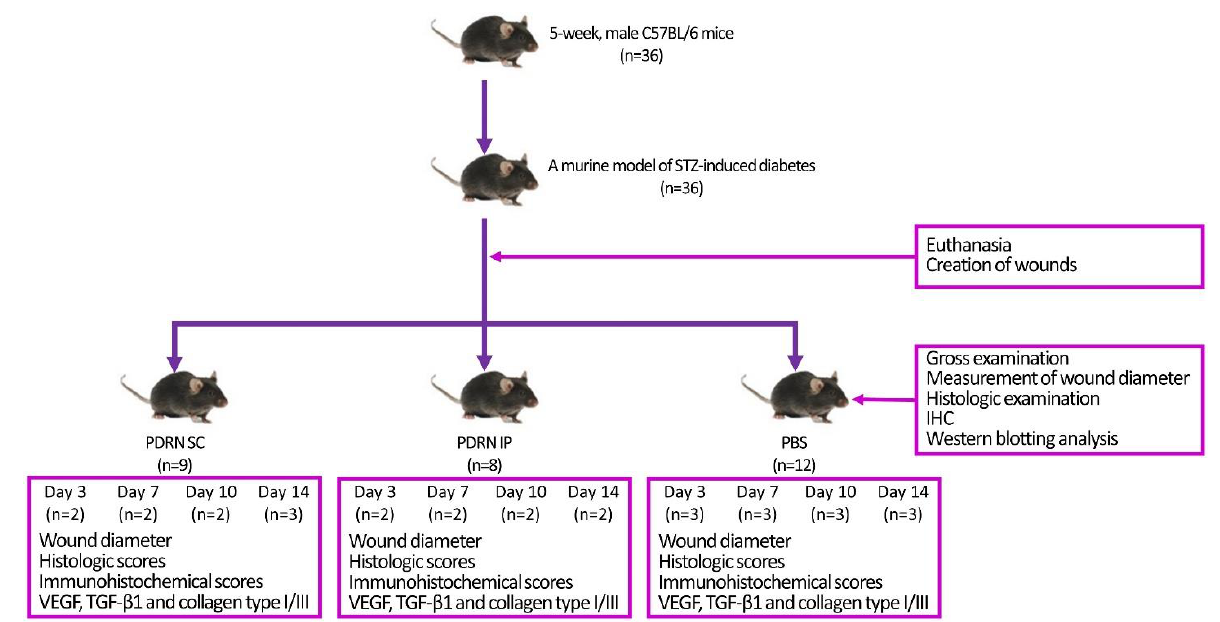
Figure 7. Experimental schema.